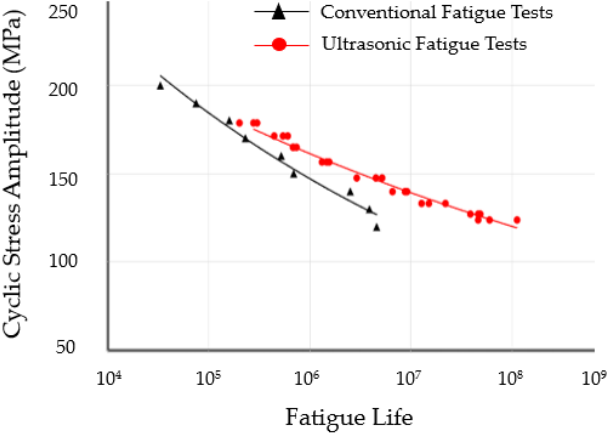
Figure 17. S-N curves of 6063 samples at different frequencies.